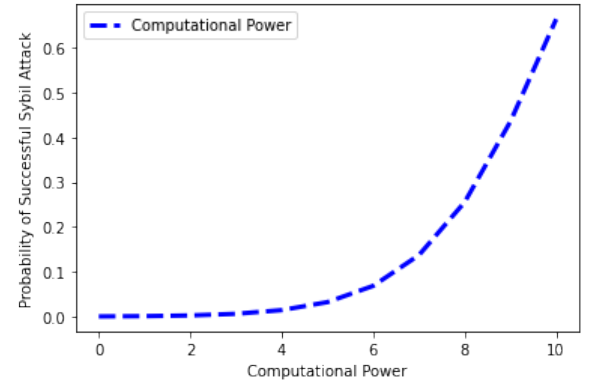
Figure 14. Sybil attack against computing